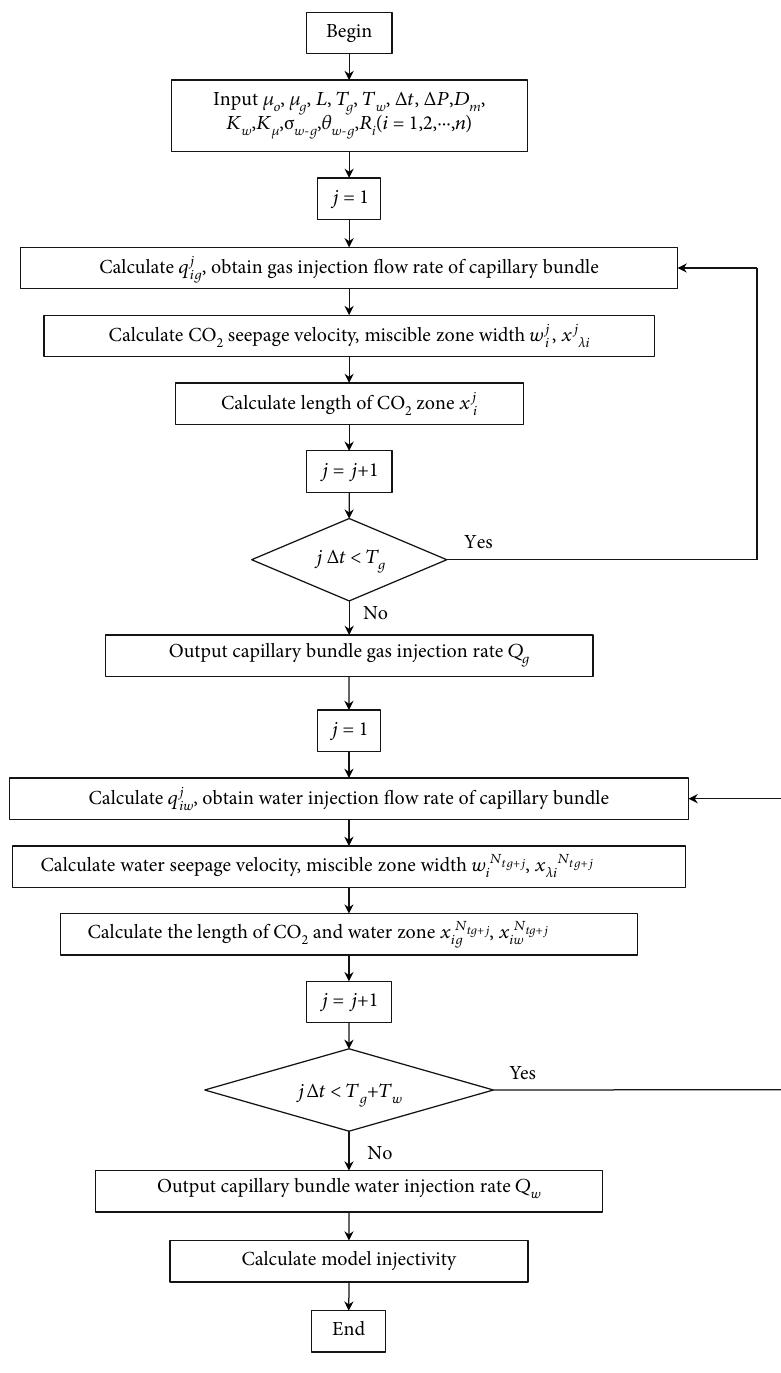
Figure 4: Flow diagram of